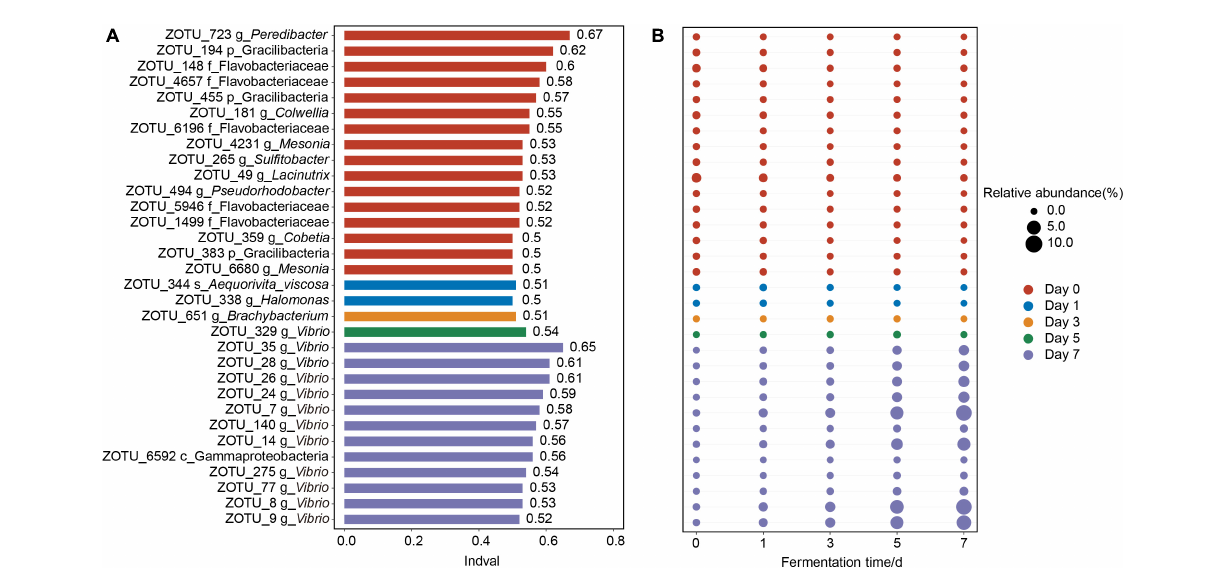
FIGURE3 The 32 indicator operational taxonomic units (OTUs) values (A) and relative abundances (B) of crab paste at day 0 (red), day 1 (blue), day 3 (orange), day 5 (green), and day 7 (purple). The length of the bar in plot (A) represents Indval of one indicator OTU. The diameters of the circles in plot (B) are proportional to the relative abundances of the OTUs, with the red, blue, orange, green, and purple circles indicating the peak relative abundances at five fermentation time points,